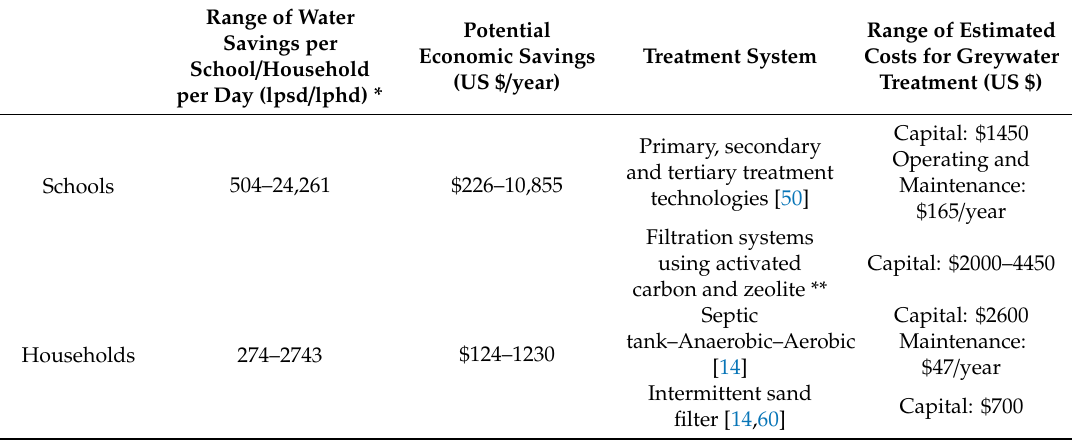
Table 4. Summary of a cost analysis of di ff erent treatment technologies applicable to schools and